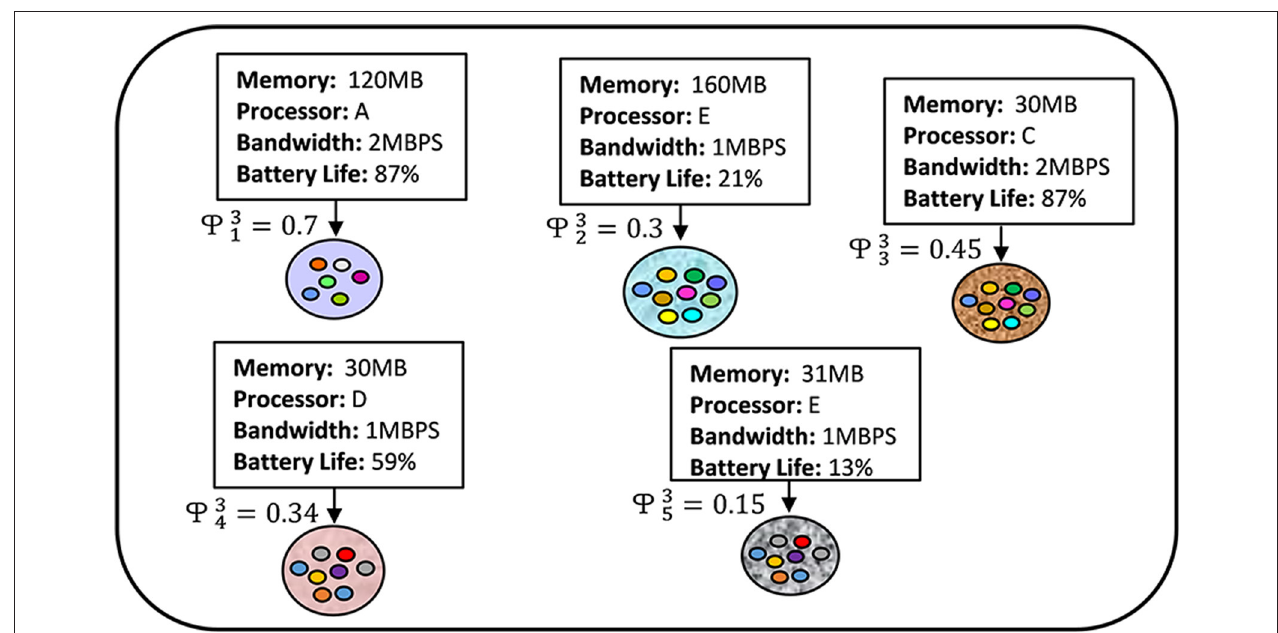
FIGURE 1 | Majority of the clients performing low-partial works that leads to slower